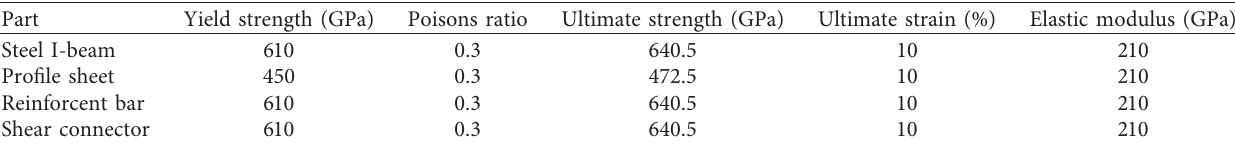
Table 2: Material properties for steel I-beam, profiled steel sheeting, reinforcement bar, and shear